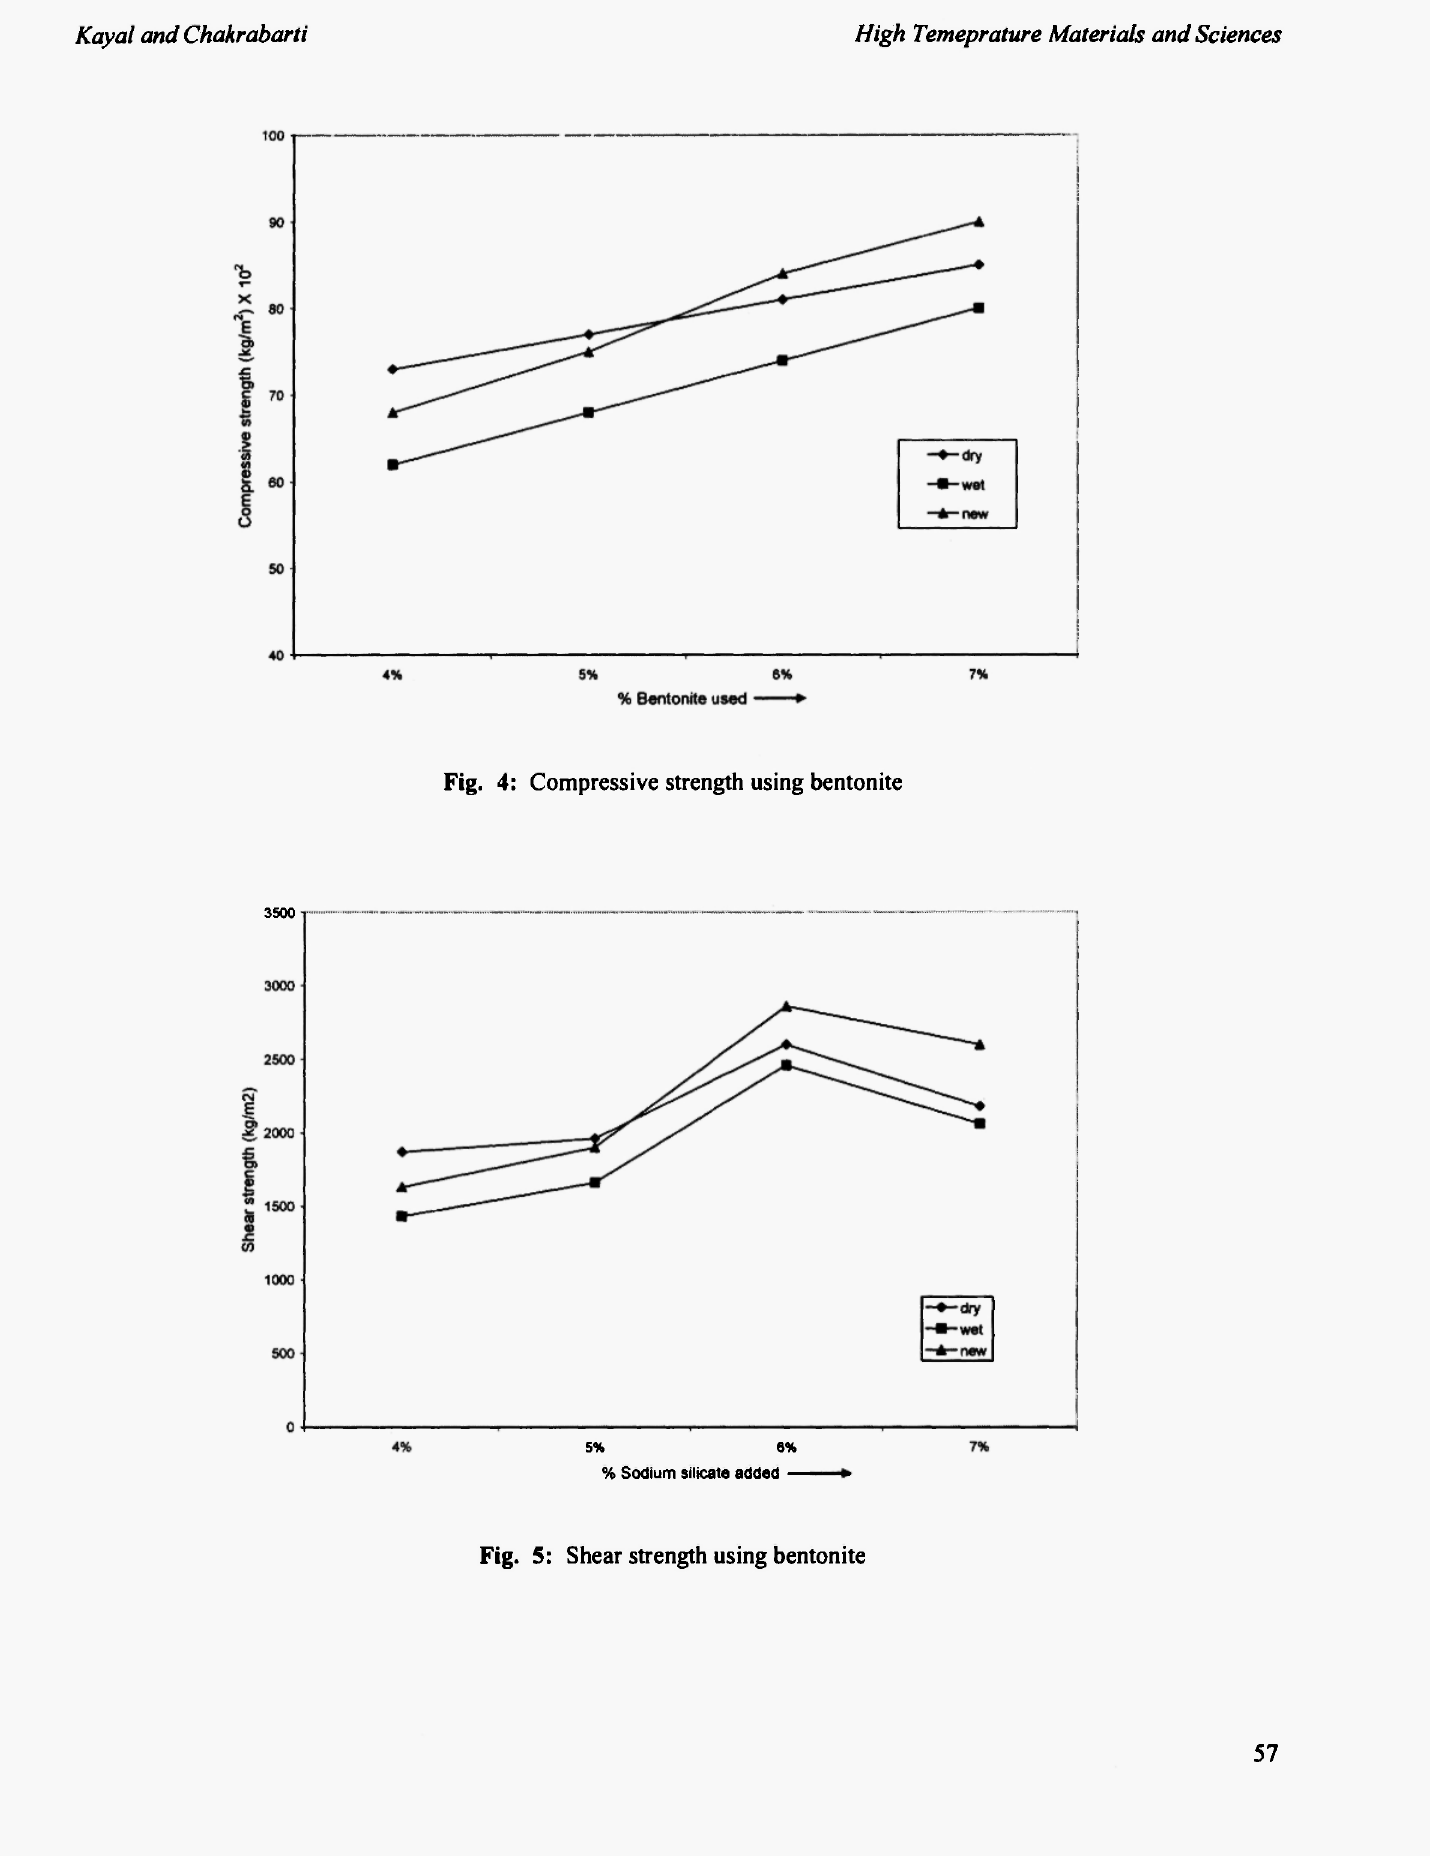
Fig. 4: Compressive strength using bentonite